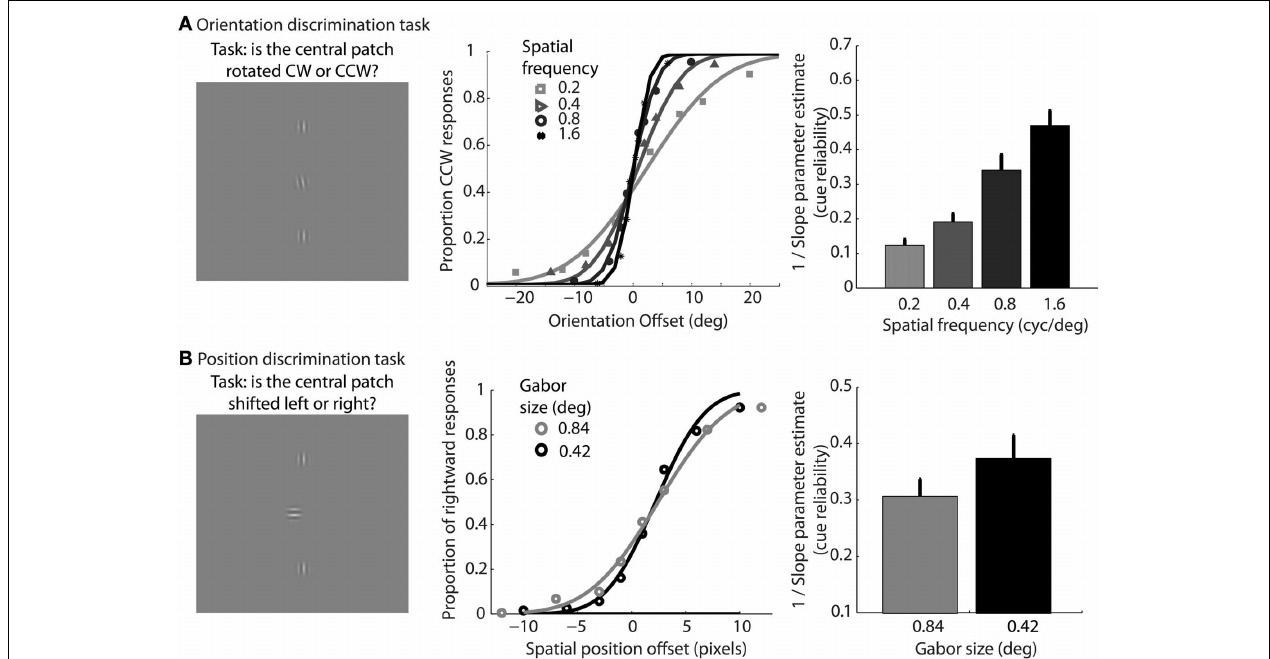
FIGURE 4 | Mean group data from Experiment 2 for the low-level orientation (A) and position (B) discrimination tasks. The left panels show example stimuli from the experiment. The middle panels show mean group data for each condition of spatial frequency as a function of orientation offset